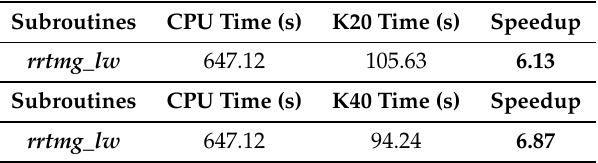
Table 4. Run-time and speedup of the 2-D G-RRTMG_LW with I/O transfer on one GPU, where the block size = 128 and ncol =